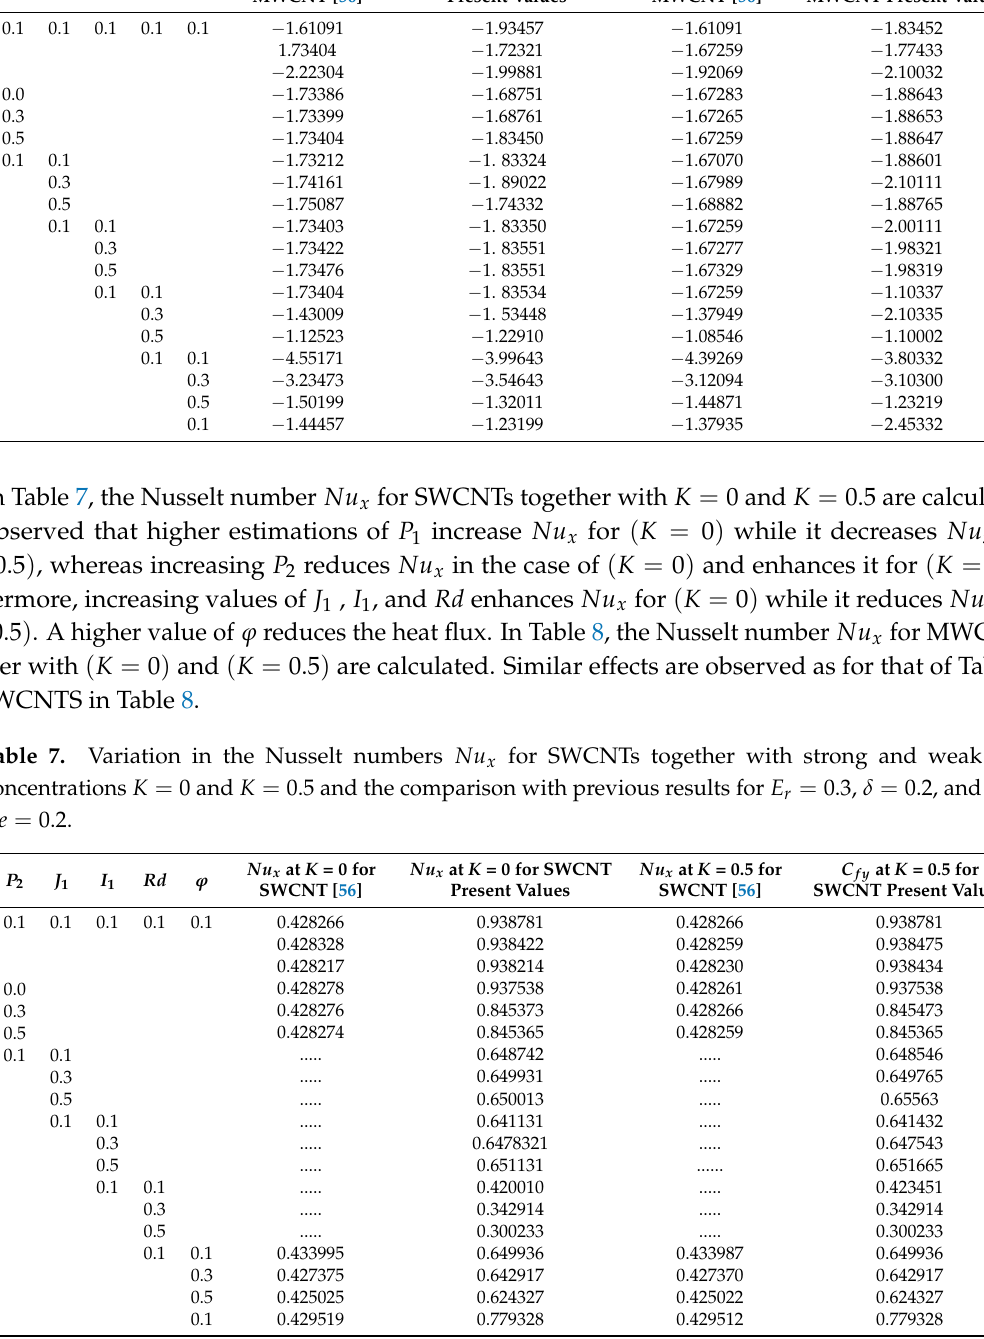
Table 6. Variation in skin-friction coefficient C fx and C fy for multi-walled carbon nanotubes (MWCNTs) together with strong and weak concentrations K = 0 and K = 0.5 and the comparison with previous results for Rd = 0.3, δ = 0.1, and Re = 0.4. C fx at K = 0 for C fx at K = 0 for MWCNT C fy at K = 0.5 for MWCNT [56] Present Values MWCNT [56]